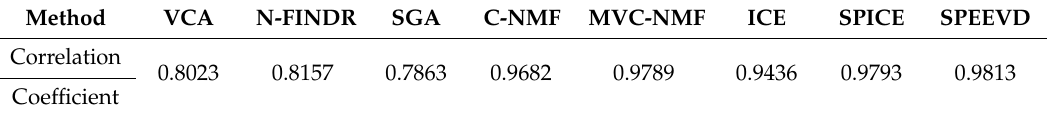
Table 5. The average correlation coefficient between the extracted endmember and USGS library spectra.